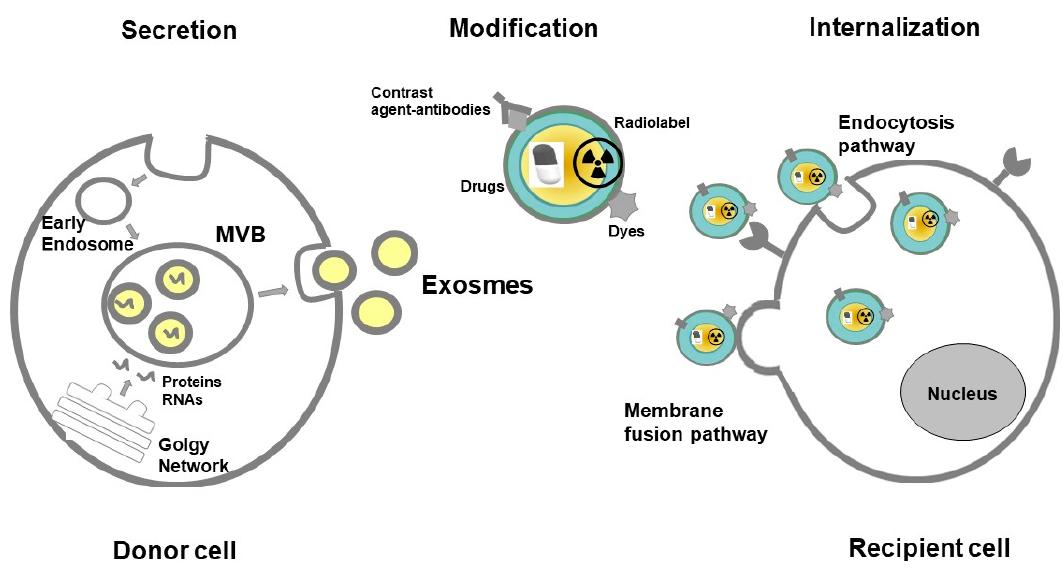
Figure 1. Pathway of exosome secretion and internalization in the human body for diagnostic and therapeutic purposes. Abbreviations: MVB—Multivesicular body.